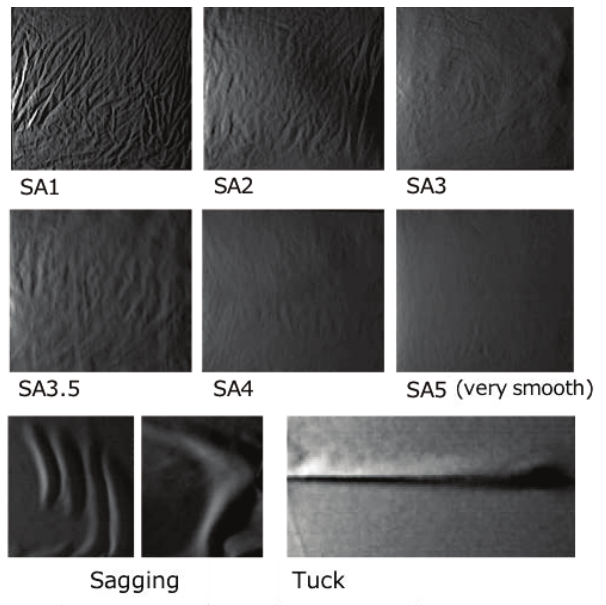
Figure 2. Infrared images of wrinkles, (cid:13)at surface, sagging, and